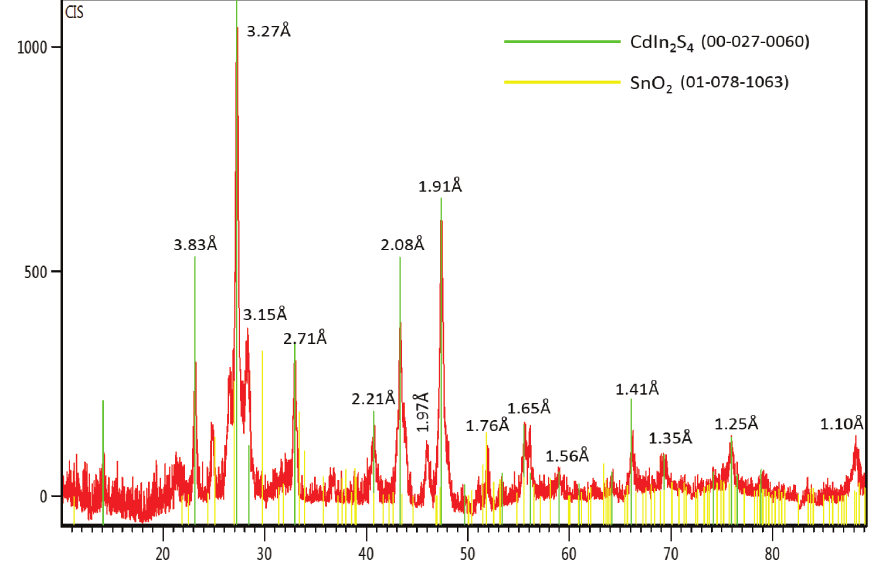
Figure A1: Sticky pattern matching with original peak pattern of CIS thin films (Indexed d-spacing) fabricated via AACVD technique at 500°C.